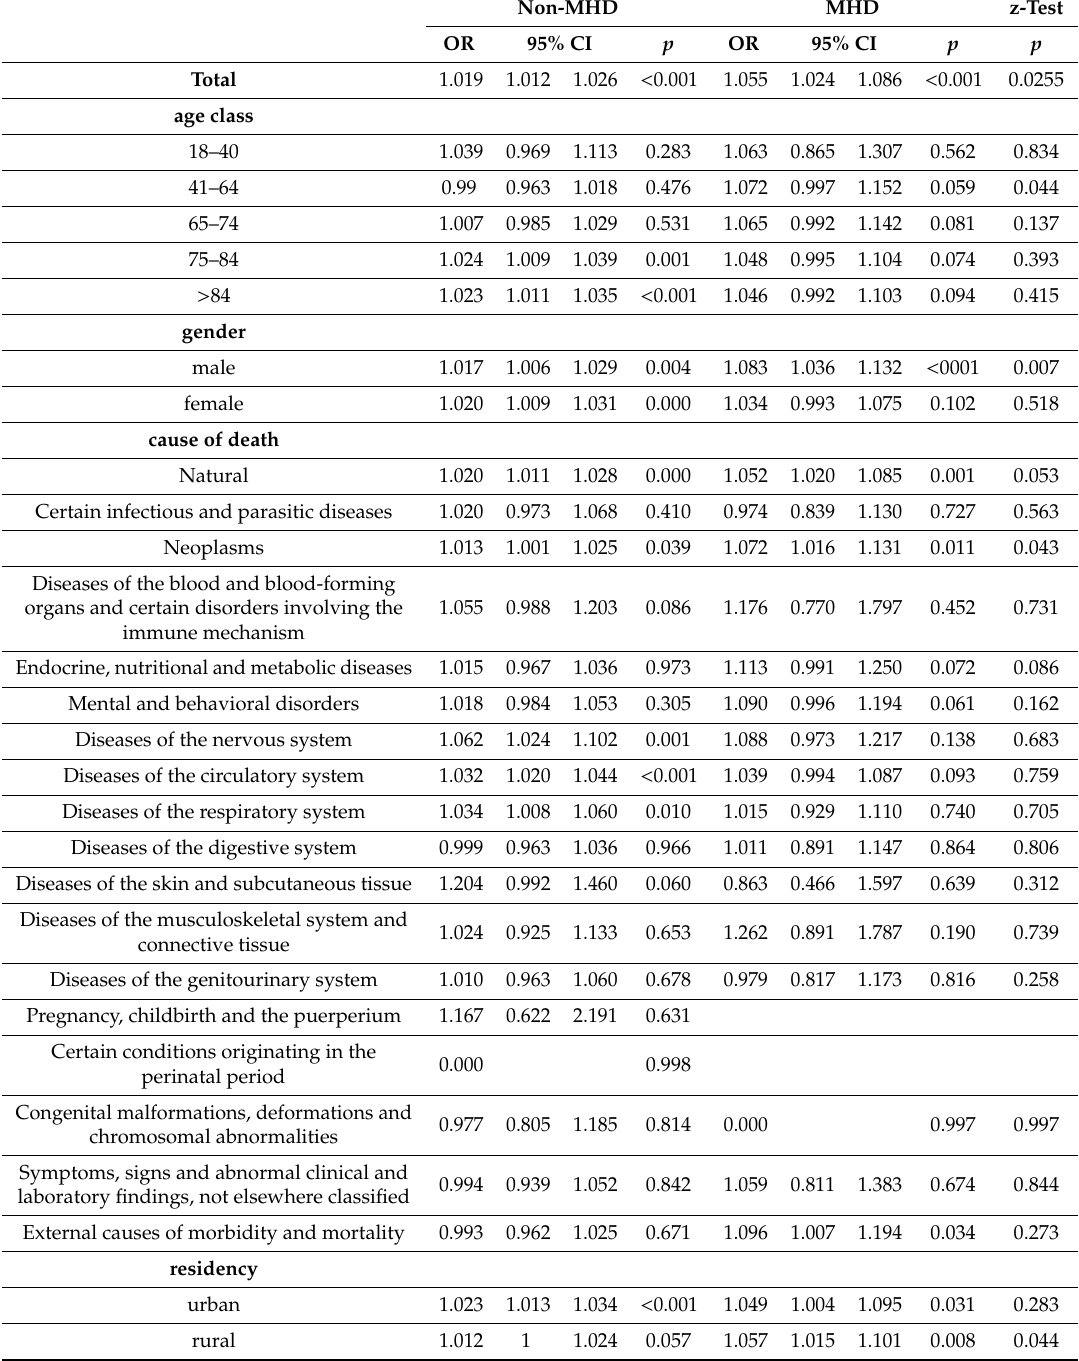
Table 3. OR (odds ratio) of dying per 1 ◦ C increase above 24 ◦ C in Mean Apparent Temperature (lag 0–1) and 95% confidence interval (CI) in the study populations by age, gender, cause of death, residency and p value of the